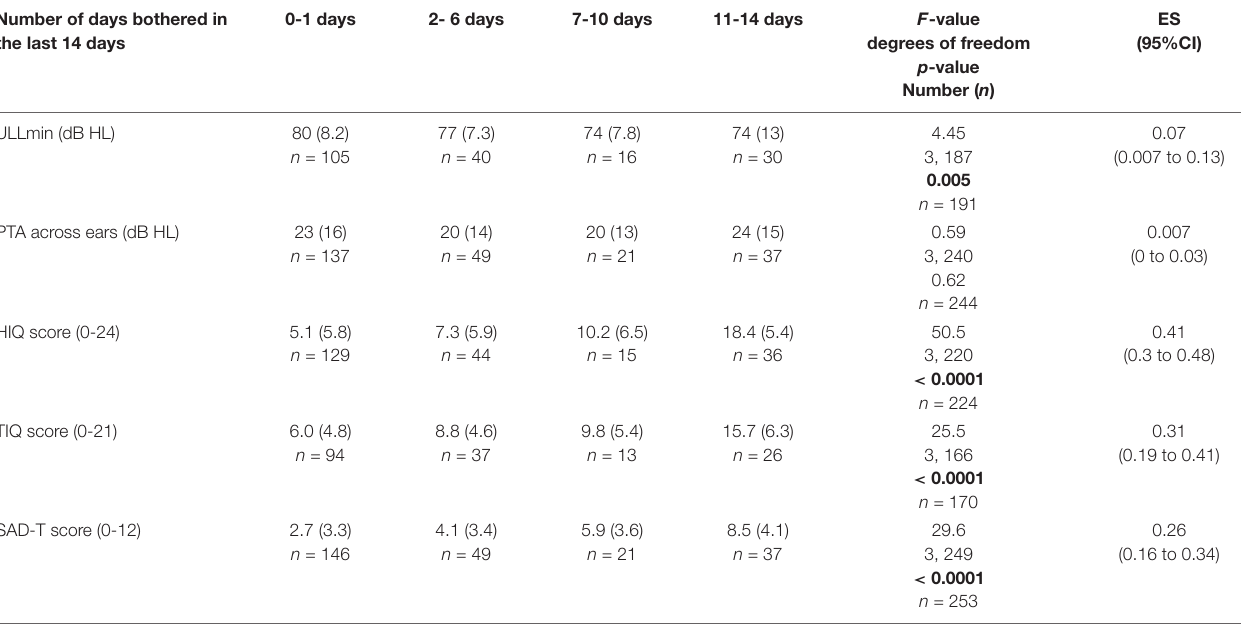
TABLE 3 | Means (SD) of ULLmin (across-frequency average uncomfortable loudness level for the ear with lower average ULL), PTA (pure tone average) across ears, and scores for the HIQ (Hyperacusis Impact Questionnaire), TIQ (Tinnitus Impact Questionnaire), and SAD-T (Screening for Anxiety and Depression-Tinnitus) for patients giving each SSSQ4 score, indicating the number of days that they were bothered by certain sounds in the last 2 weeks. Number of days bothered in the last 14 days